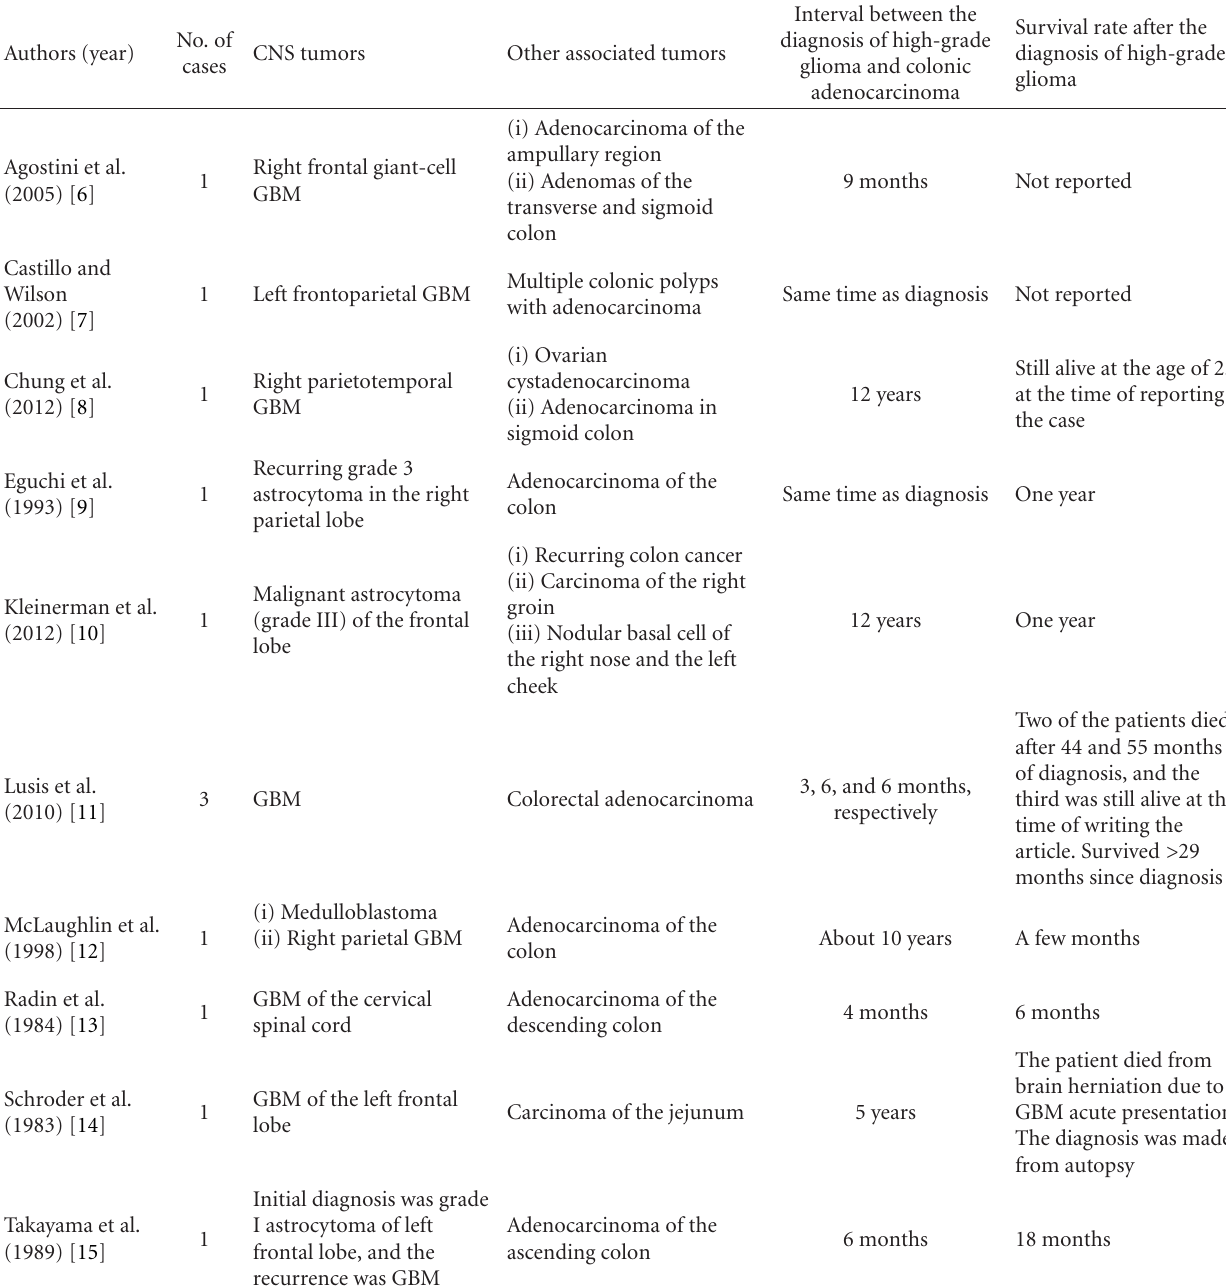
Table 1: Summary of selected reported cases with high-grade glioma and adenocarcinoma of the